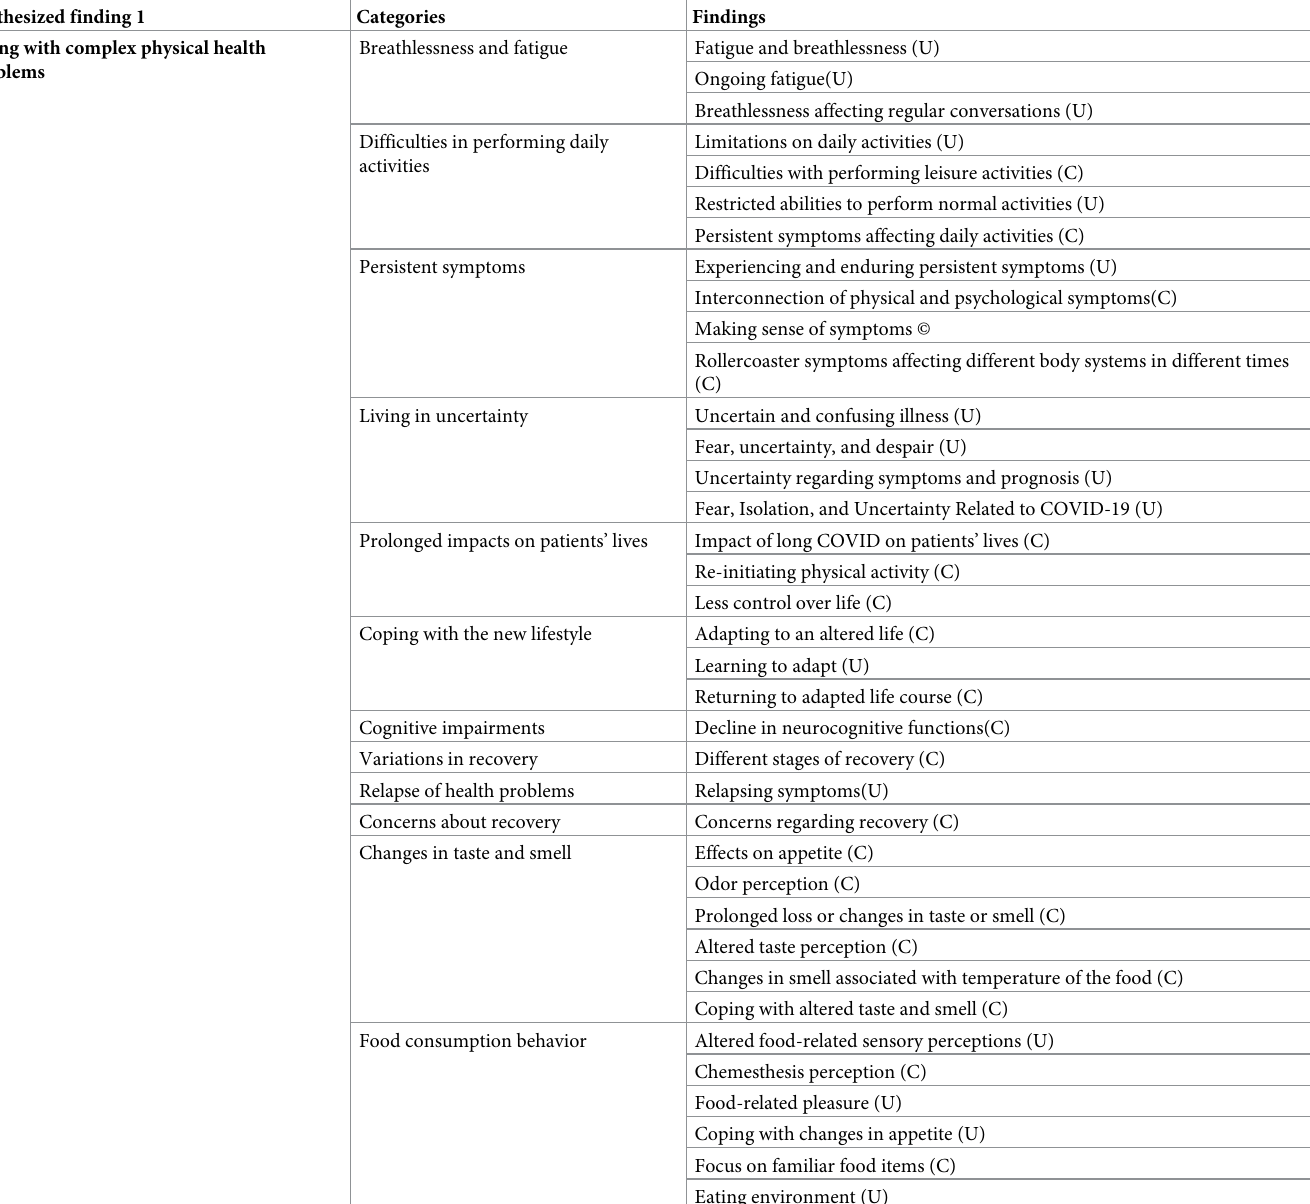
Table 3. Findings and categories within synthesized finding